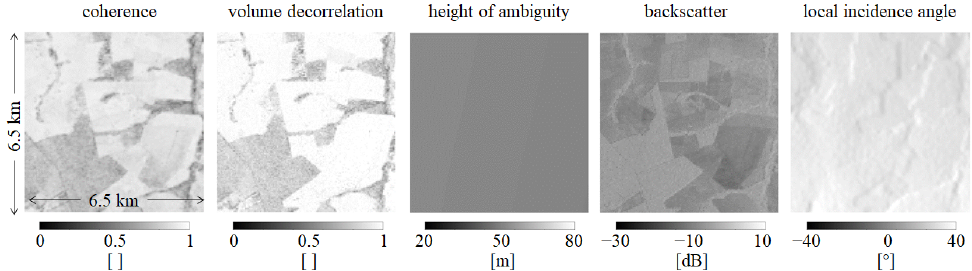
Figure 3. Example of input features patches of 128 × 128 pixels (6.4 km × 6.4 km): (from left-to- right) the interferometric coherence, the volume decorrelation factor, the height of ambiguity, the backscatter, and the local incidence